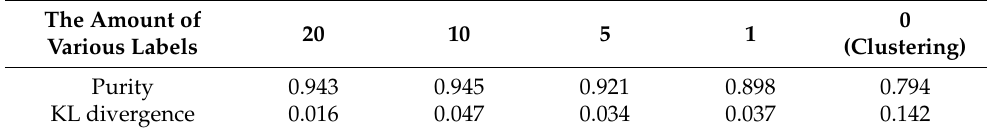
Table 2. Experimental results of different training